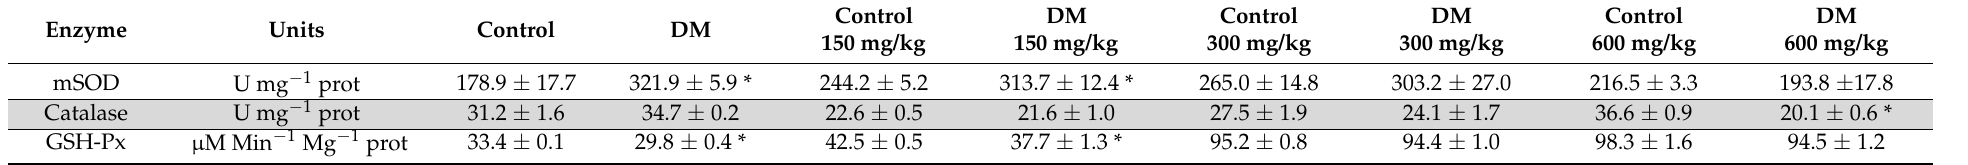
Table 2. Enzymatic determination for superoxide dismutase, catalase, and glutathione